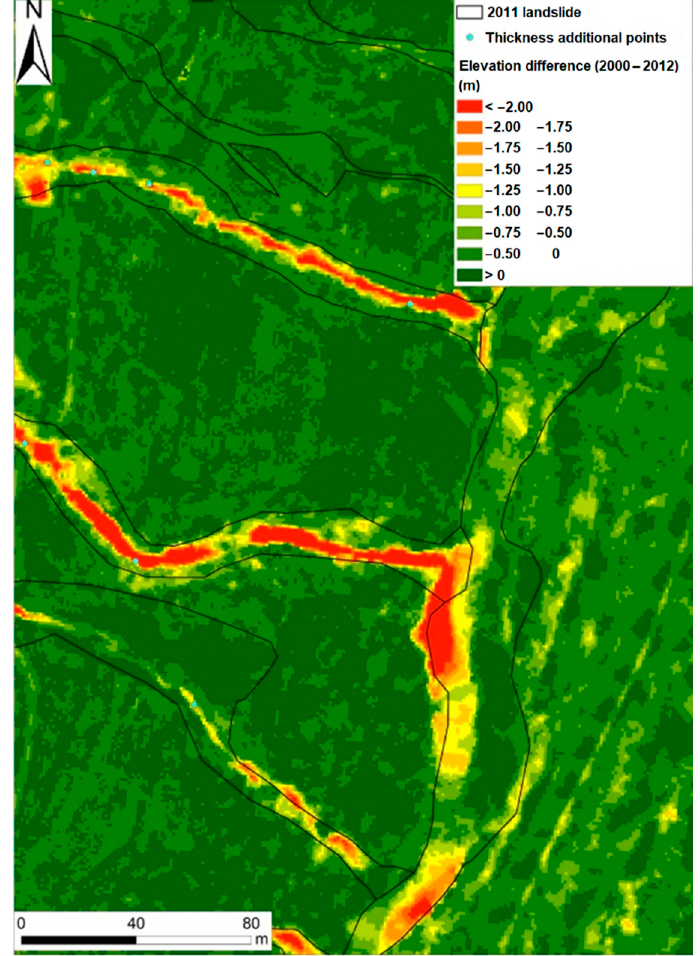
Figure 5. Pre-2000 and post-2012 event digital elevation models (DEMs) illustrating the elevation differences after the 2011 landslide event in Kvam area.